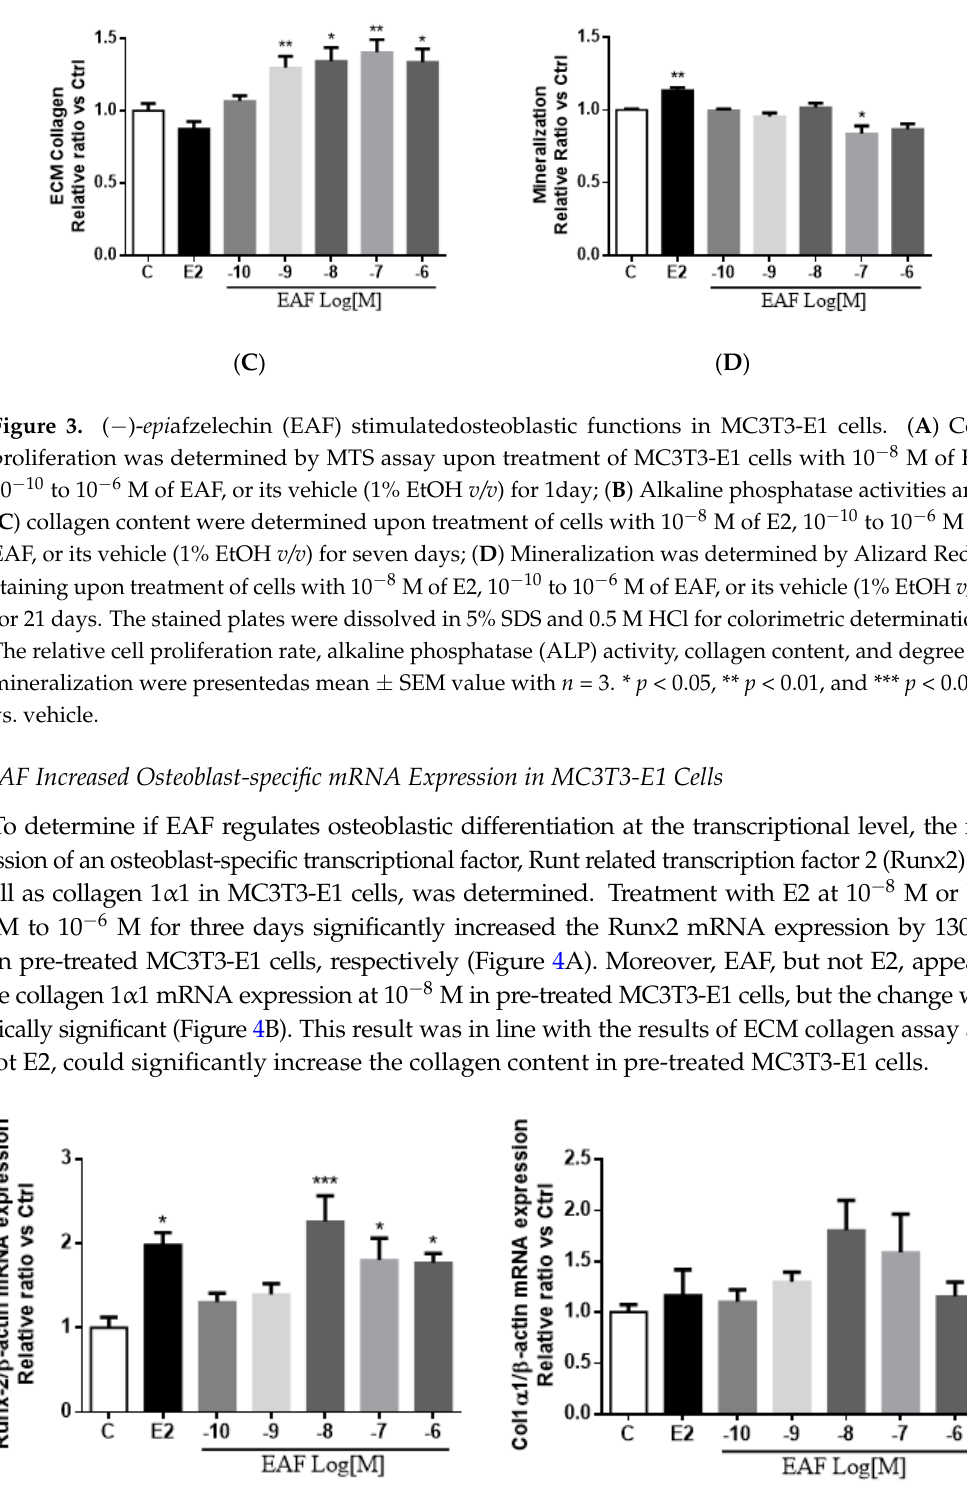
Figure 4. EAF stimulatedosteoblast-specific mRNA expression in MC3T3-E1 cells. The mRNA expression level of ( A ) Runx2 and ( B ) Col 1 α 1 in MC3T3-E1 cells upon treatment with 10 − 8 M of E2, 10 − 10 to 10 − 6 M of EAF, or its vehicle (1% EtOH v/v ) for three days was determined by reverse-transcriptase real time polymerase chain reaction analysis. The relative gene expressions were expressed as mean ± SEM value. * p < 0.05, and *** p < 0.001 vs. control.